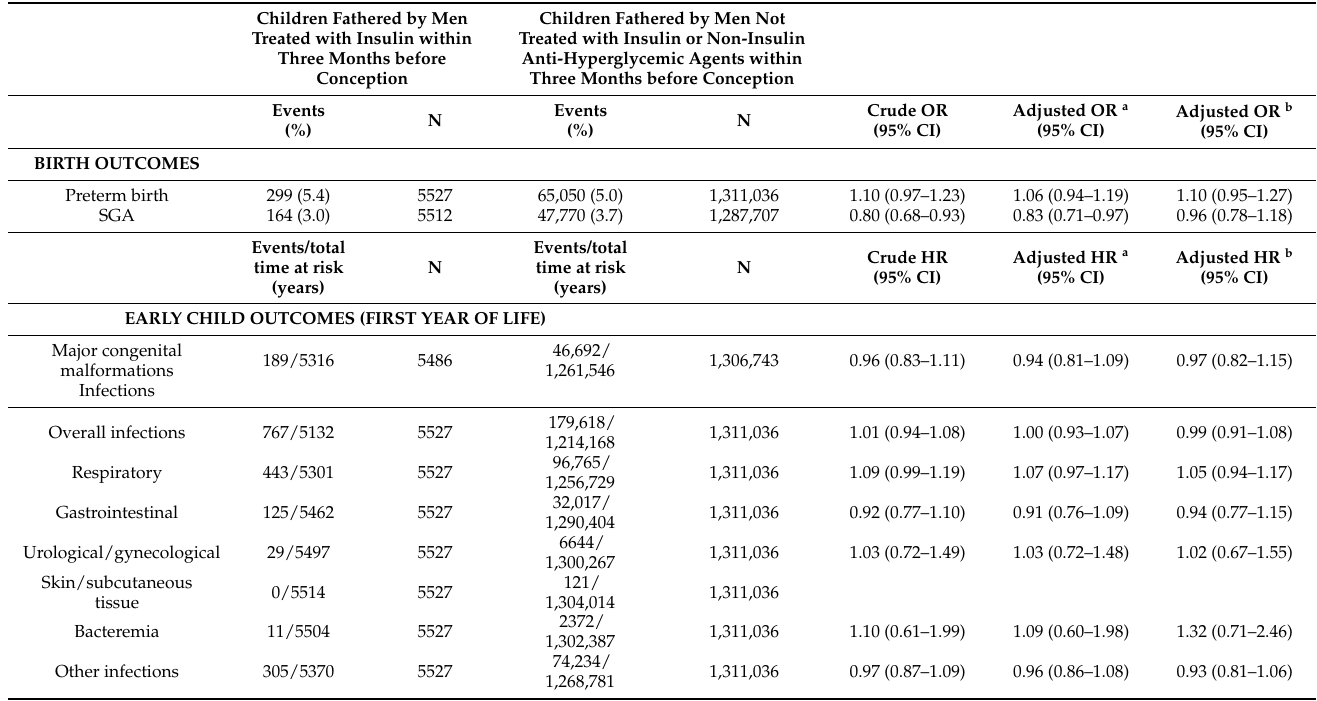
Table 2. Crude and adjusted odds ratio (OR), with 95% confidence interval (CI), for preterm birth and small for gestational age (SGA) in live born singletons fathered by men treated with insulin before conception, and the crude and adjusted hazard ratios (HR) for congenital abnormalities and early life infections in live born singletons fathered by men treated with insulin before